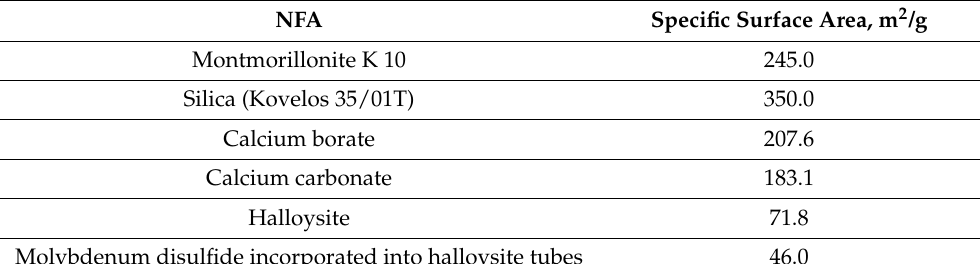
Table 1. The characteristics of NFAs.